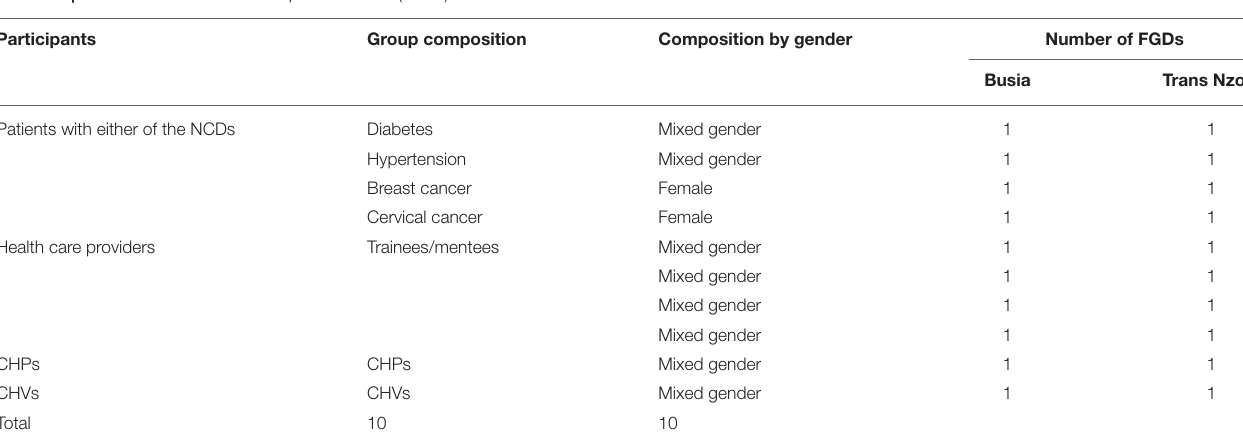
TABLE 2 | Recruitment for Focus Group Discussions